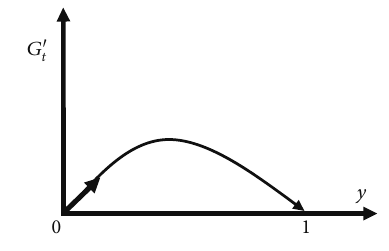
Figure 3: Customers select honest strategy.